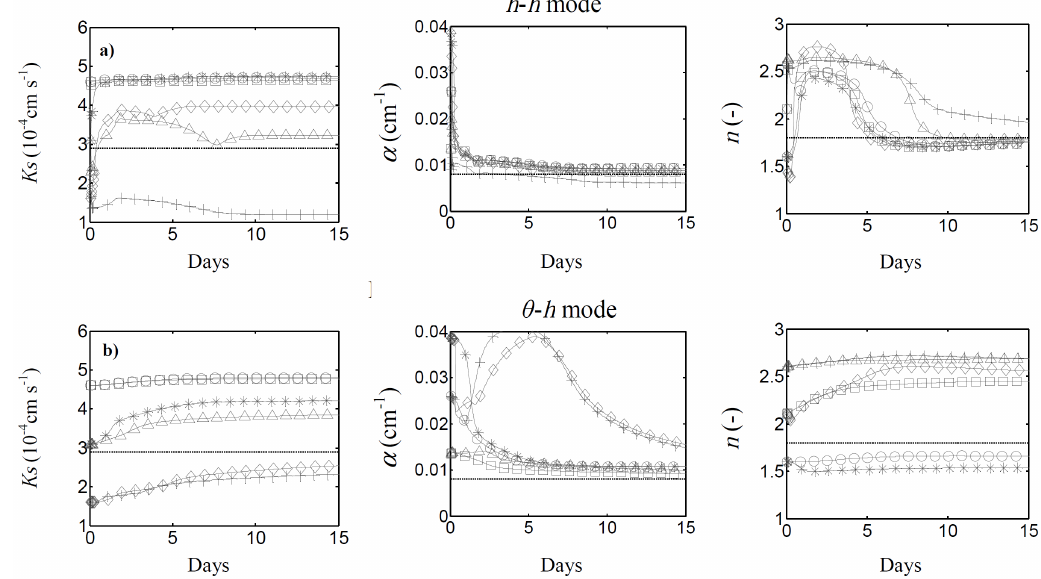
Figure 9. VGM parameters K s , α and n retrieved with the DSUKF algorithm, using (a) the h - h and (b) θ - h retrieval modes by assimilating observations every hour, with observation depth OD = 10cm. Comparisons account for the six pondered sets of initial parameters: S1( (cid:13) ) , S2( (cid:3) ) , S3( ∗ ) , S4( 1) , S5( + ) and S6( ♦ )